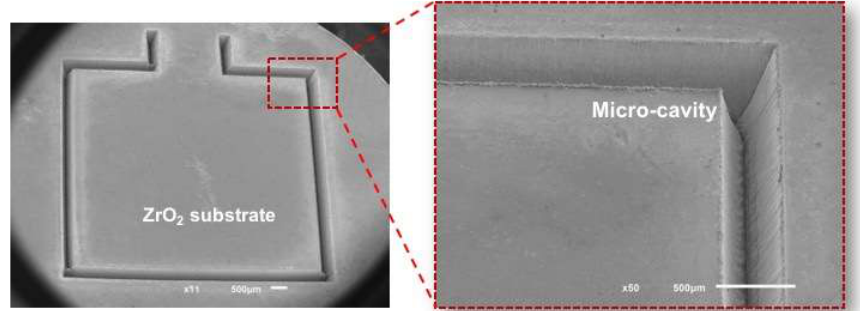
Figure 6. Micro-cavity of the antenna created by laser on zirconia surface. After the micro-cavity was created on the surface, the silver powder was placed into the cavity and consolidated by a laser sintering approach (additive process). Figure 7 shows a part of the antenna path before and after laser sintering.